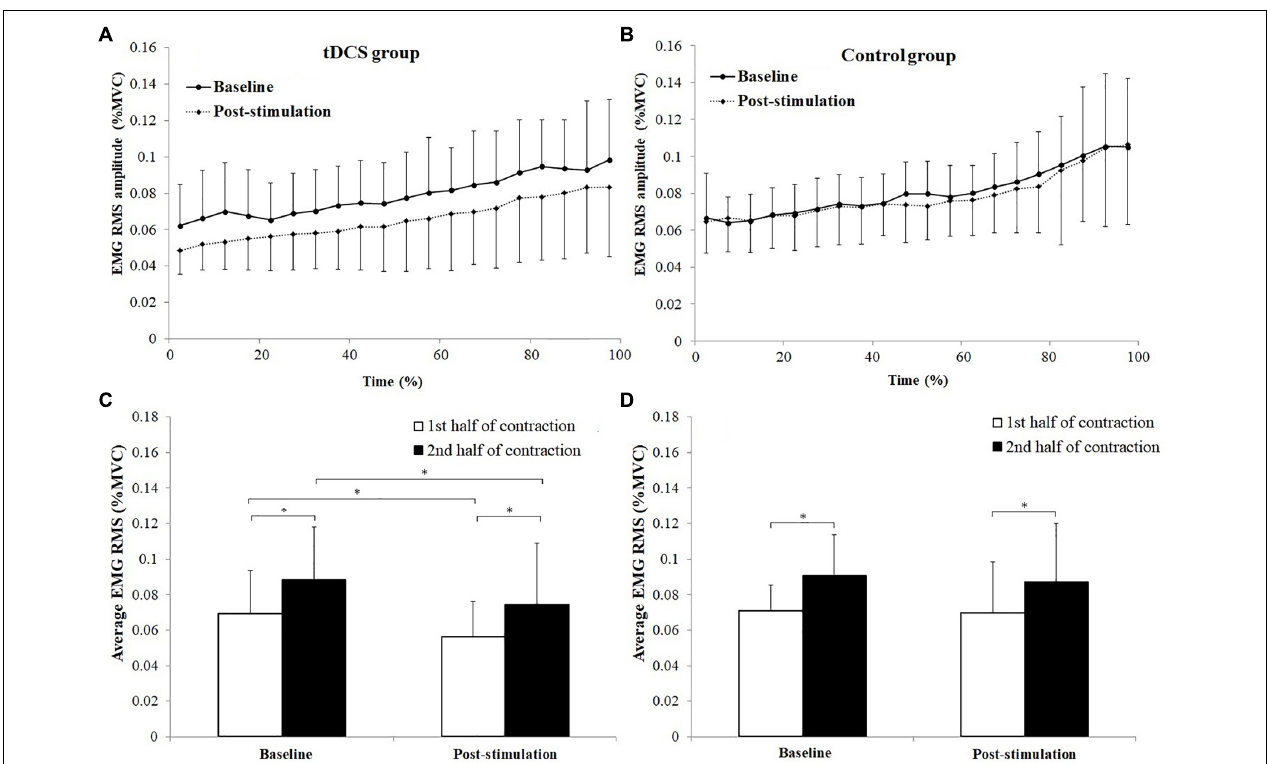
FIGURE 6 | Changes of antagonist muscle coactivation level of triceps brachii (TB) during the sustained fatiguing elbow flexion contraction (A,B) and comparisons of average electromyography (EMG) root mean square (RMS) [% maximum voluntary contraction (MVC)] between the 1st and 2nd half of contraction for baseline and post-stimulation test in transcranial direct current stimulation (tDCS) (C) and control (D) group subjects. Data have been expressed as mean ± SD values. *demonstrated a significant difference of observed index between the baseline and post-stimulation test or between the 1st and 2nd half of